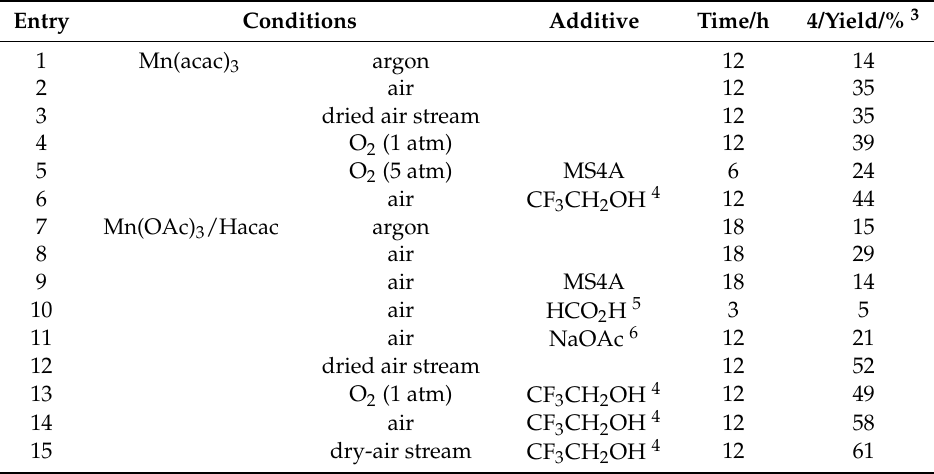
Table 1. Reaction of Mn(acac) 3 1 and 2,4-Pentanedione (Hacac) with Mn(OAc) 3 in AcOH 2